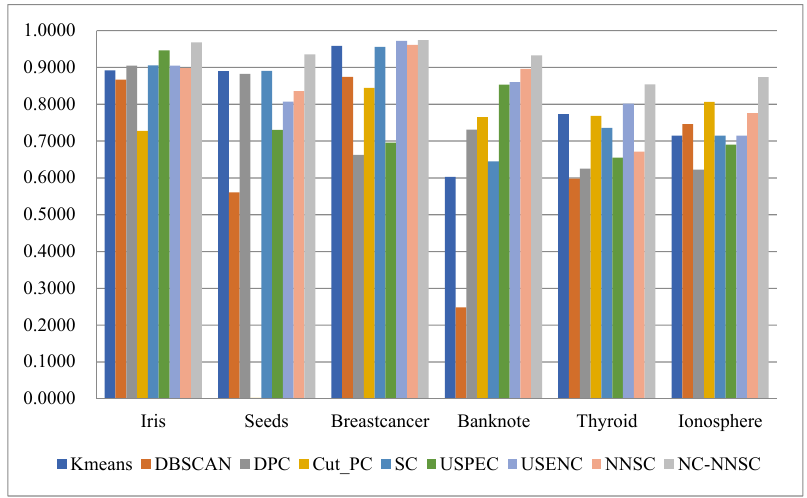
Figure 17. The F-measure index of different clustering algorithms in six real-world datasets.